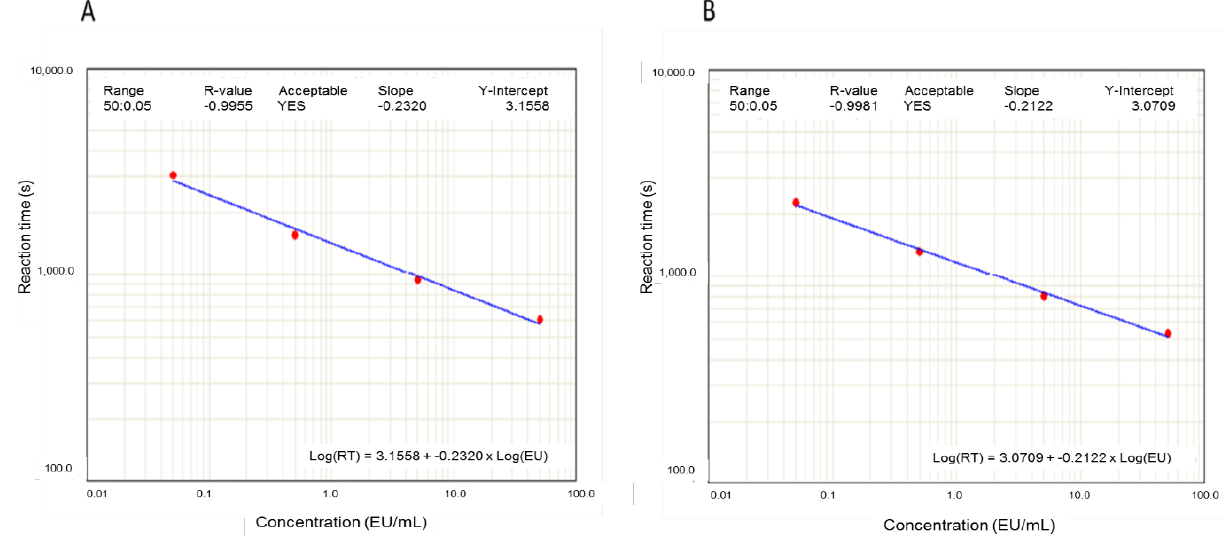
Figure 1. Calibration curves obtained with endotoxin standards (50, 5, 0.5, and 0.05 EU/mL). Effect of filtration: ( A ): Unfiltered standards; ( B ): Filtered standards. EU: endotoxin units.